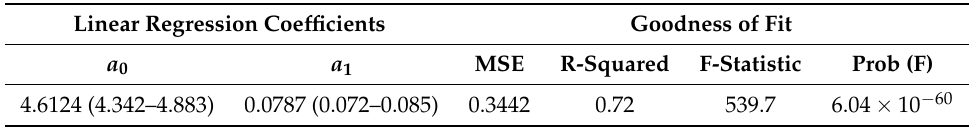
Figure 7. Traffic data and predictions using the linear model. Colors represent the real traffic category of the predictions. Table 4. Model coefficients (with confidence interval in parenthesis) and goodness of fit metrics for traffic vs. power